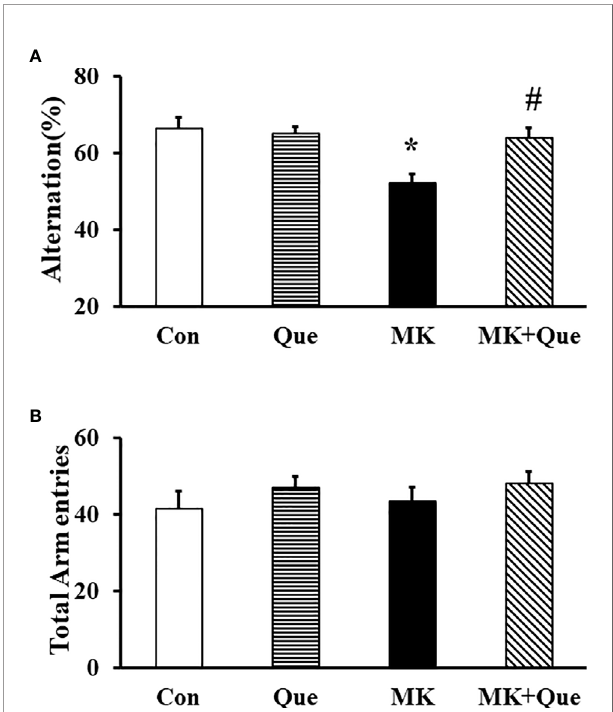
FIGURE 2 | Spatial working memory in the mice of control (Con), quetiapine (Que), MK-801 (MK), and MK-801+quetiapine (MK+Que) groups. Quetiapine attenuated the decrease of spontaneous alternation behavior in the MK-801 mice (A) , and quetiapine and MK-801 had no effect on the number of total arm entries (B) during the Y-maze test in mice. n=10 in each group. Mice were treated with chronic quetiapine (10 mg/kg/day, intraperitoneally) for 28 days. From day 22 to 28, 1 h after the administration of quetiapine, the mice were administered MK-801 (2 mg/kg/day, subcutaneously). On day 30, spatial working memory performance in mice was assessed by recording spontaneous alternation behavior in a Y-maze. Results are expressed as means ± S.E.M. * P < 0.05 vs. Con, # P < 0.05 vs.